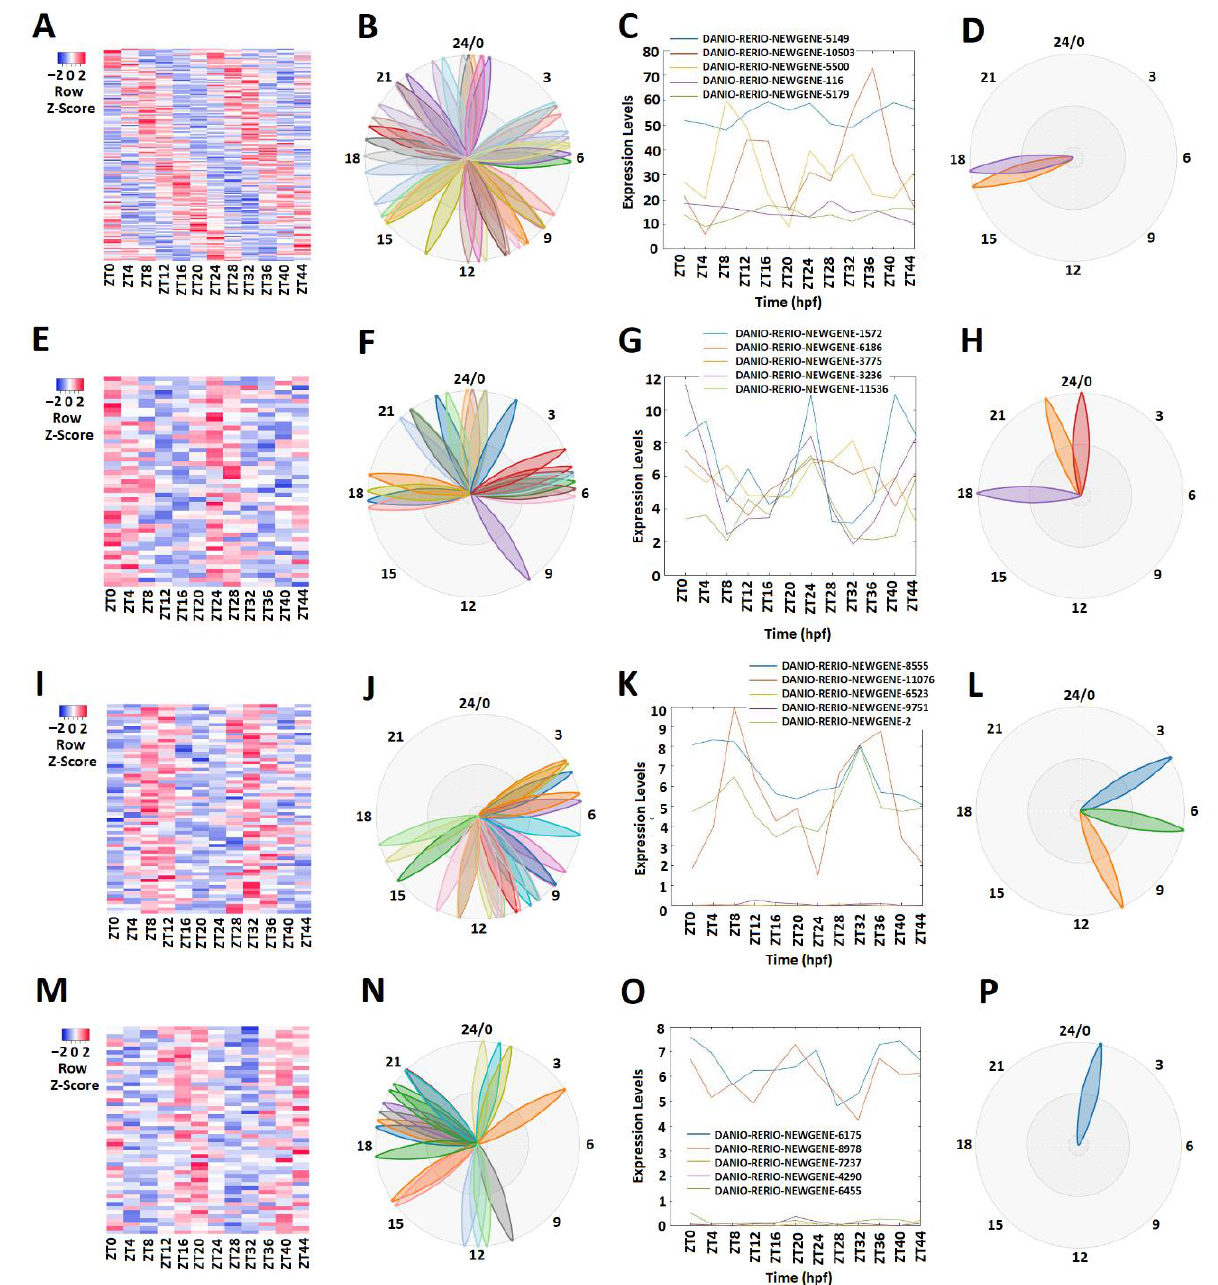
Figure 3. Expression profile analysis of morning (ZT 0 and ZT4), evening (ZT8 and ZT12), and night (ZT 16 and ZT 20) rhythmically expressed testis lncRNAs. Analysis of all 165 rhythmically expressed testis lncRNAs ( A – D ): heat map ( A ) and phases ( B ) of all 165 rhythmically expressed testis lncRNAs; expression profiles ( C ) and phases ( D ) of representative lncRNAs. Analysis of 47 testis morning lncRNAs ( E – H ): heat map ( E ) and phases ( F ) of 47 testis morning lncRNAs; expression profiles ( G ) and phases ( H ) of representative testis morning lncRNAs. Analysis of 66 testis evening lncRNAs ( I – L ): heat map ( I ) and phases ( J ) of 66 testis evening lncRNAs; expression profiles ( K ) and phases ( L ) of representative testis evening lncRNAs. Analysis of 52 testis lncRNAs ( M – P ): heat map ( M ) and phases ( N ) of 52 testis night lncRNAs; expression profiles ( O ) and phases ( P ) of representative testis night lncRNAs.